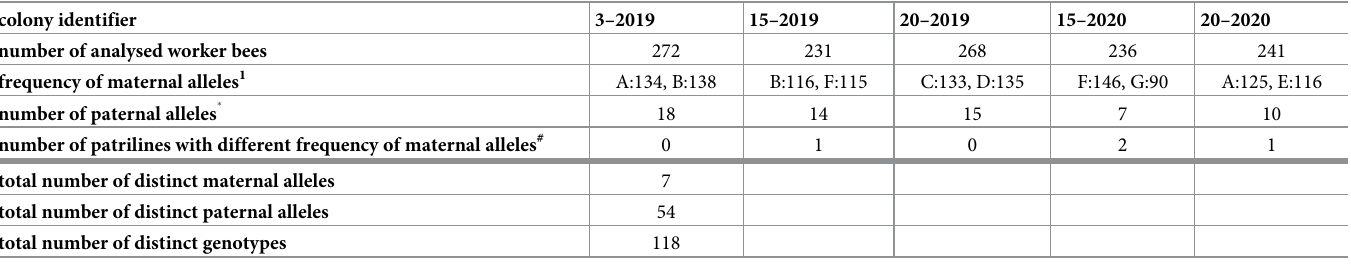
Table 2. Summary of the identified csd alleles and genotypes in the analysed colonies. colony identifier